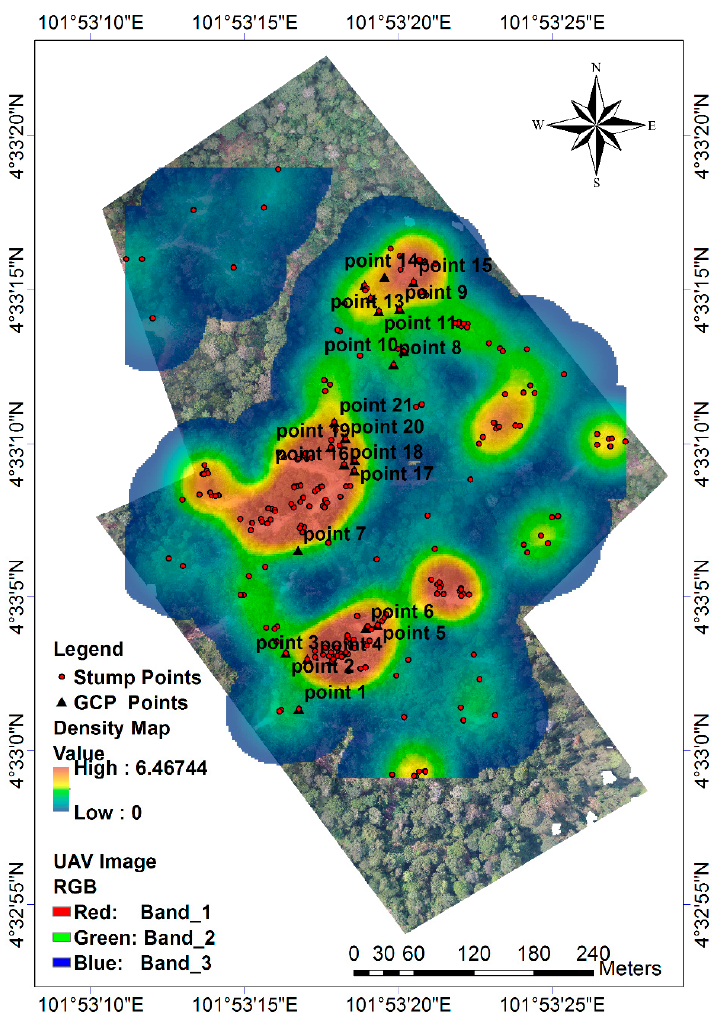
Figure 11. Stump detection density map using the integrated TM and OBIA approach with kernel density. The warmer colour reflects regions with dense stumps, whereas the cooler colour depicts areas with fewer stumps.